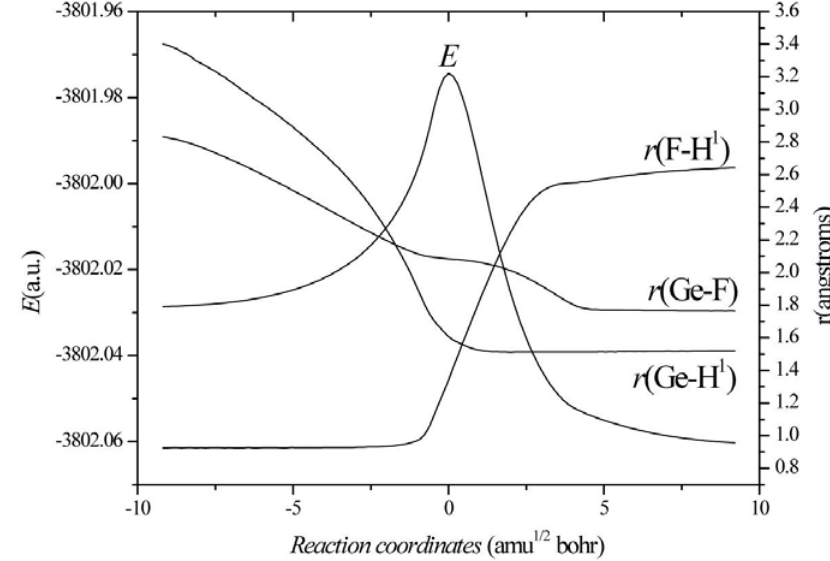
Figure 4. The changes of energies and bond distances along the reaction coordinate of the reaction of H